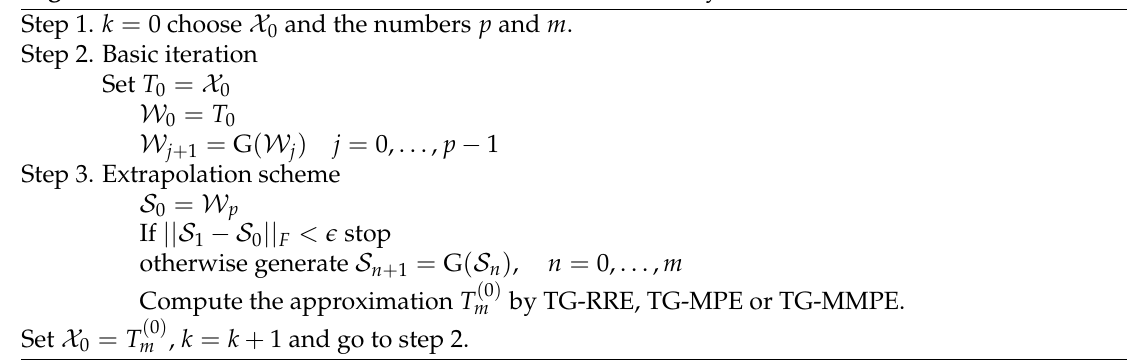
Algorithm 2 TG-RRE, TG-MPE and TG-MMPE for nonlinear systems